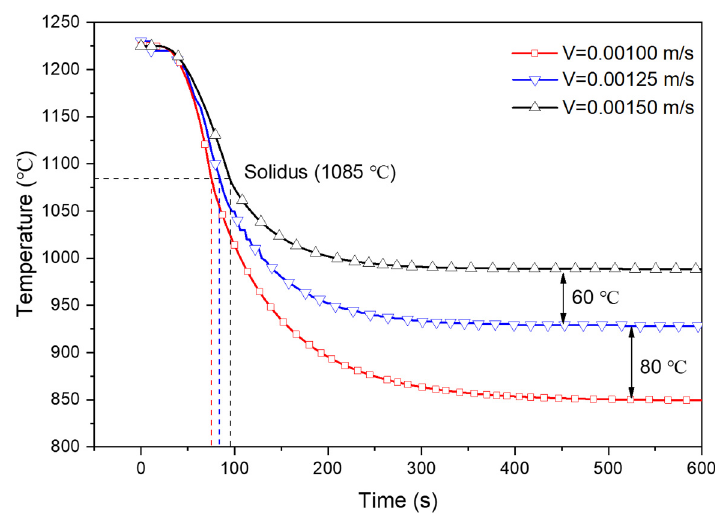
Figure 12. Changes in melt temperature at point C shown in Figure 6 from the initial conditions to steady ‐ state casting at different casting speeds.